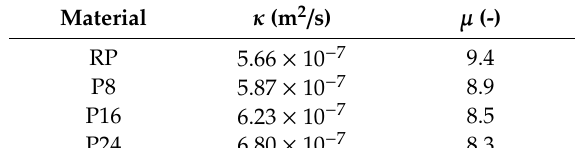
Table 6. Hygric properties of the studied plasters.